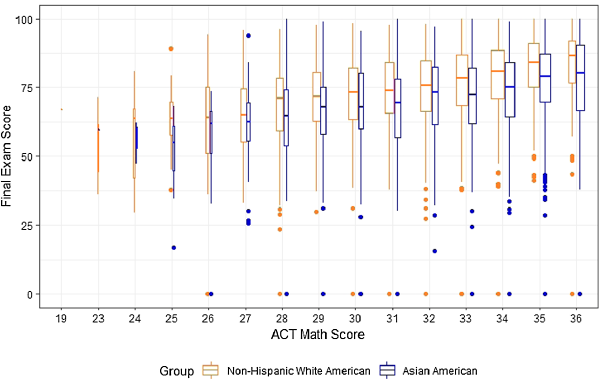
FIG. 3. Asian American and non-Hispanic White American student performance on the final exam by ACT math score.